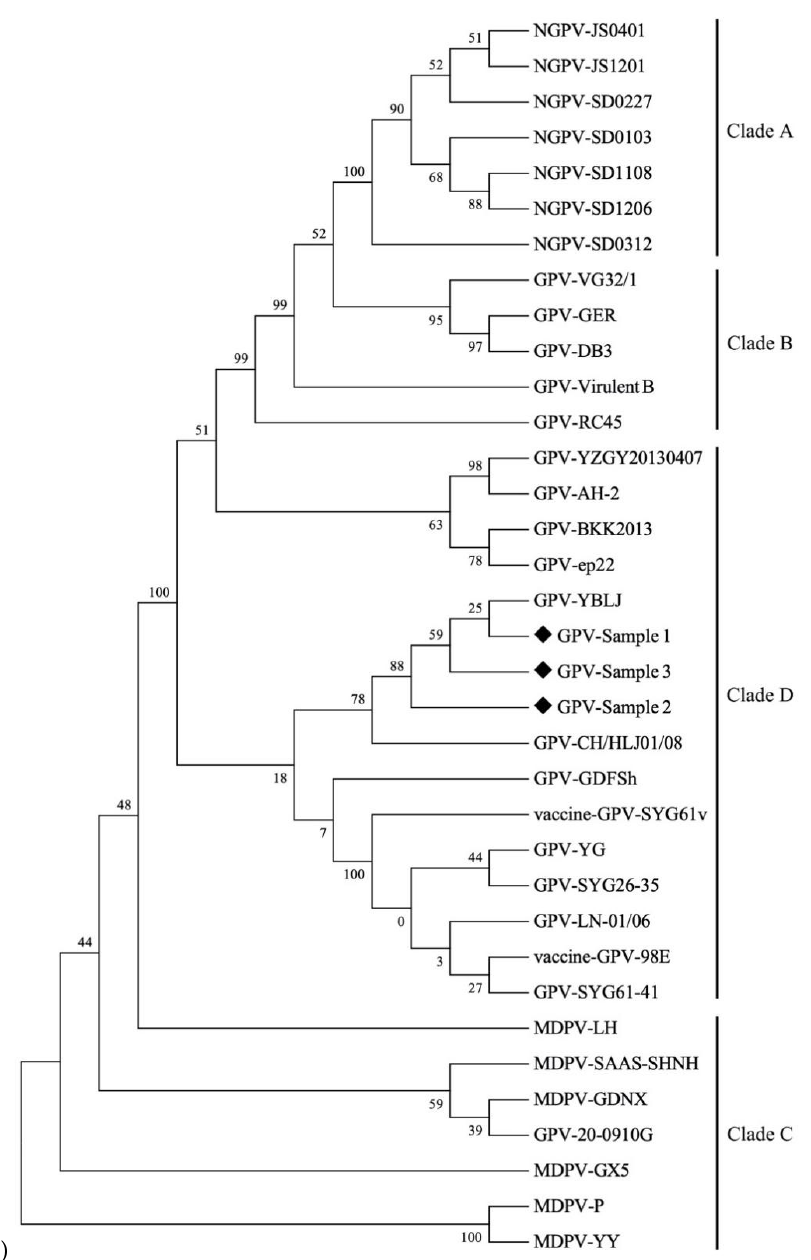
Figure 6. Phylogenetic analysis of GPV with other viruses based on the VP3 nucleotide sequences: ( a ) neighbor-Joining (N–J) method; ( b ) maximum likelihood (M–L) method. The phylogenetic tree was based on the complete VP3 sequences of GPV, together with GPV, nGPV, and MDPV. Nucleotide sequences were analyzed using the MEGA 6.0 software with a bootstrap test of 1000 replicates. The clades were used to differentiate between the different strains. The substitution model was HKY+G. The diamond-shaped icons ( ◆ ) were the clinical samples in this study.